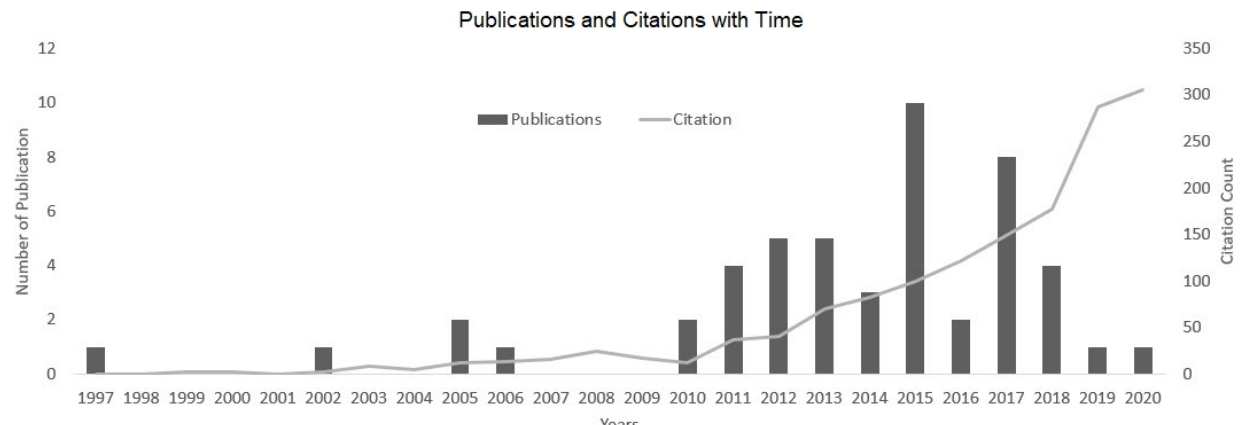
Figure 2. Publication and citation of identified articles with time.